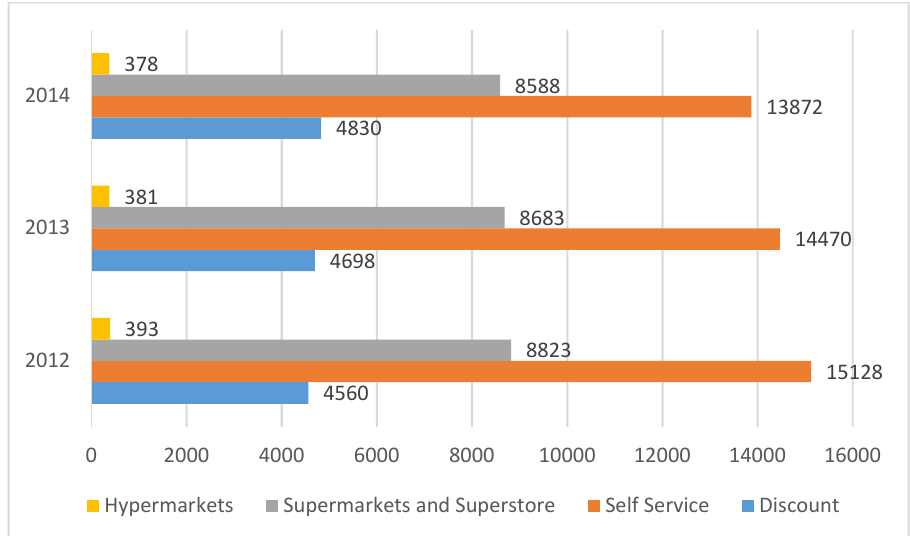
Figure 2: Number of Points of Sale by Format - Years